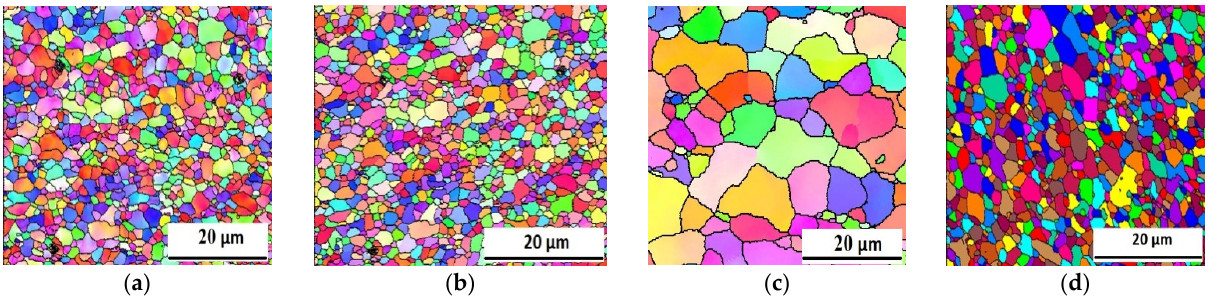
Figure 3. EBSD micrograph of Al 5083 alloy after ECAPed processing ( a ) no pass, ( b ) first pass, ( c ) second pass, ( d ) third pass at high temperature.